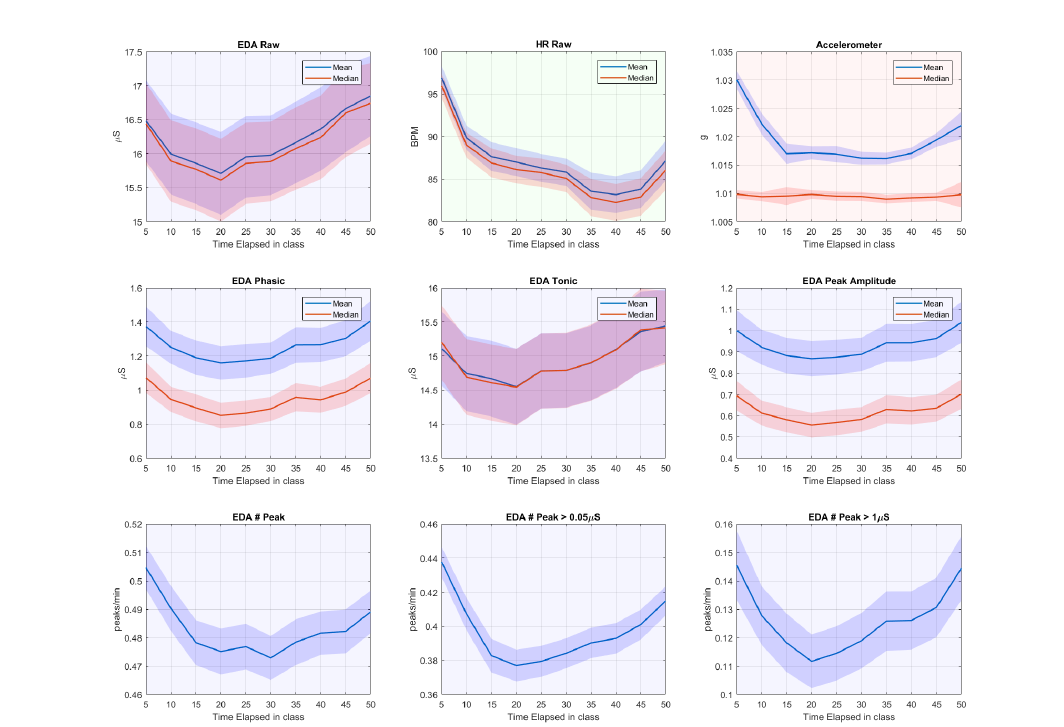
Figure 9. Features of EDA, HR, and accelerometer data over the course of 50-min class. A shade area √ N where N = 85 participants for EDA and accelerometer and 80 participants for HR. represents SD/